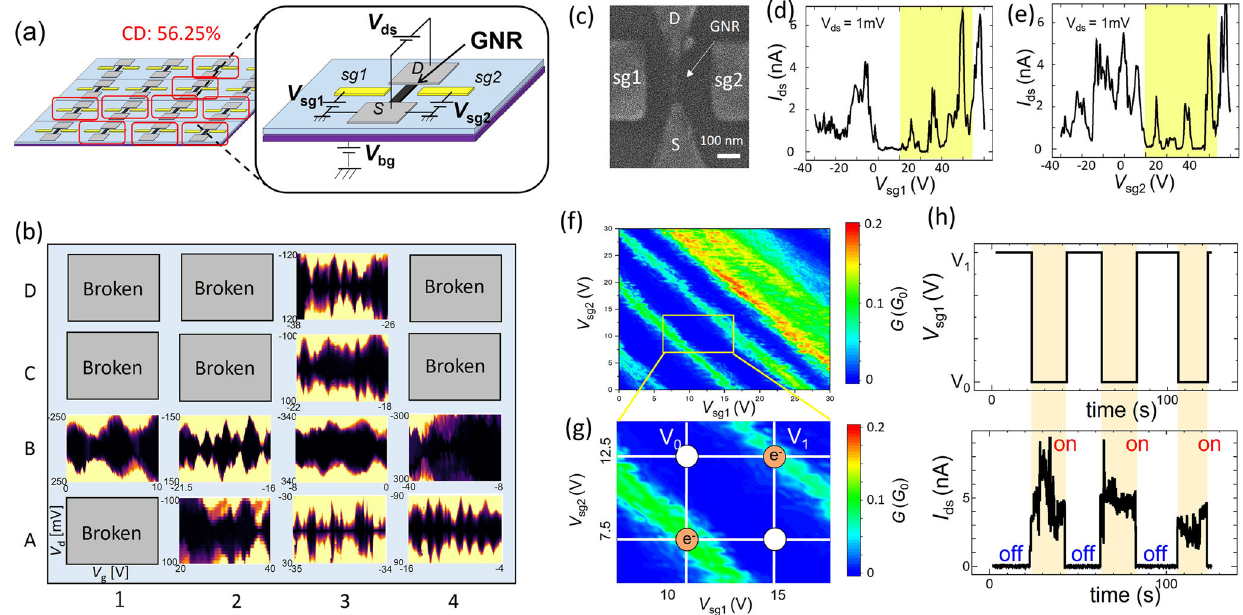
Fig. 3 Site-controlled fabrication of integrated GNR-based QD devices. a Typical illustration of device patterns and detailed device structures. ( b ) All 16 GNR-device features measured at 15 K were fabricated within the same substrate. c Typical SEM image and d , e Coulomb oscillation features of GNR-based QD devices operated by d sg1 and e sg2. Contour plot of G / G 0 as functions of V sg1 and V sg2 swept in f wide and g narrow ranges. h (top) Time pro fi le of V V I V SG1 switched between 0 and 1 and (bottom) its ds response.